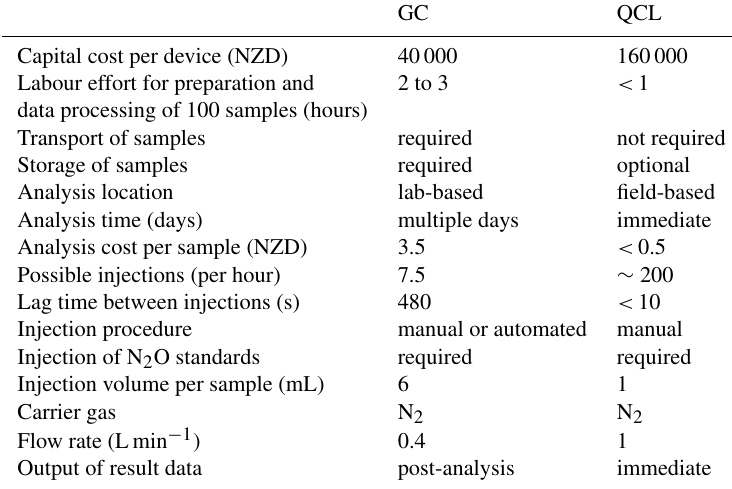
Table 1. The GC and QCL methods in comparison: details provided in the table relate to this study, and the information provided was not generalised. NZD: New Zealand dollars. GC QCL Capital cost per device (NZD) 40000 160000 Labour effort for preparation and 2 to 3 < 1 data processing of 100 samples (hours) Transport of samples required not required Storage of samples required optional Analysis location lab-based field-based Analysis time (days) multiple days immediate Analysis cost per sample (NZD) 3.5 < 0.5 Possible injections (per hour) 7.5 ∼ 200 Lag time between injections (s) 480 < 10 Injection procedure manual or automated manual Injection of N 2 O standards required required Injection volume per sample (mL) 6